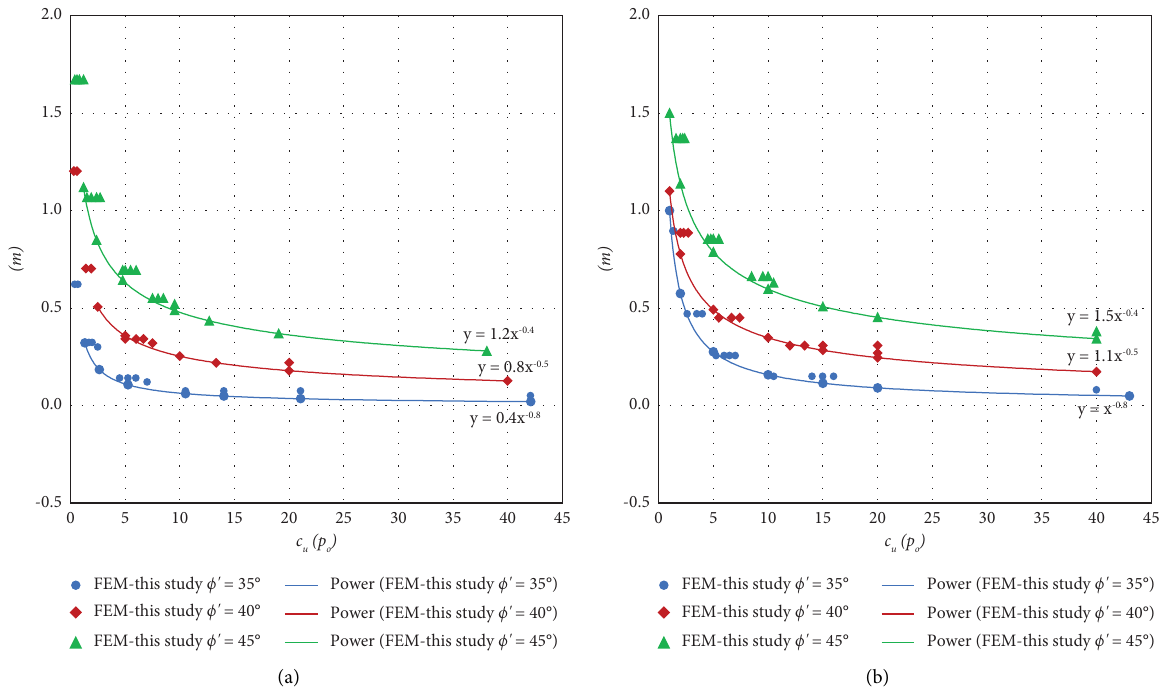
Figure 14: Design curves for square footing on an unstabilised and geogrid-stabilised granular layer over clay. (a) Nonstabilised. (b) Geogrid-stabilised.